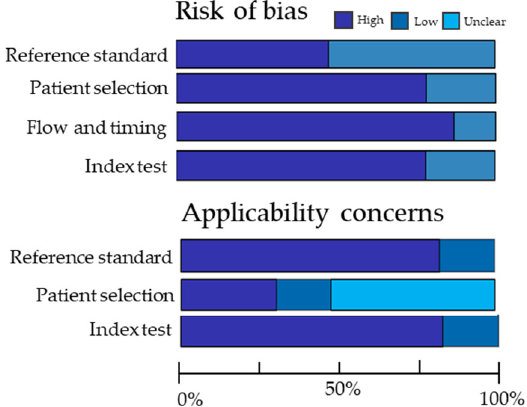
Figure 2. Summary of Methodological Quality Scored According to Quality Assessment of Diag- nostic Accuracy Studies Tool, Version 2 (QUADAS-2) for 23 articles discussing the topic of response monitoring.